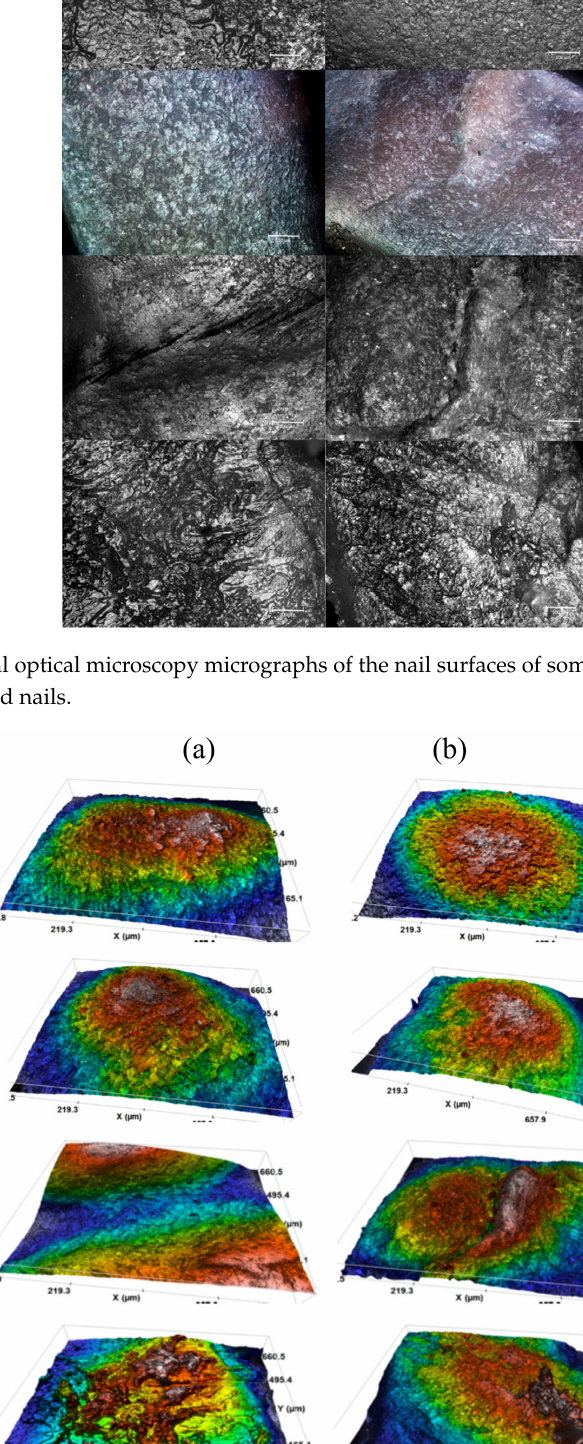
Figure 9 . Images of the models of the dorsal surface of the nails of several volunteers obtained by non- contact 3D surface profilometry. ( a ) Treated nails, ( b ) untreated nails.